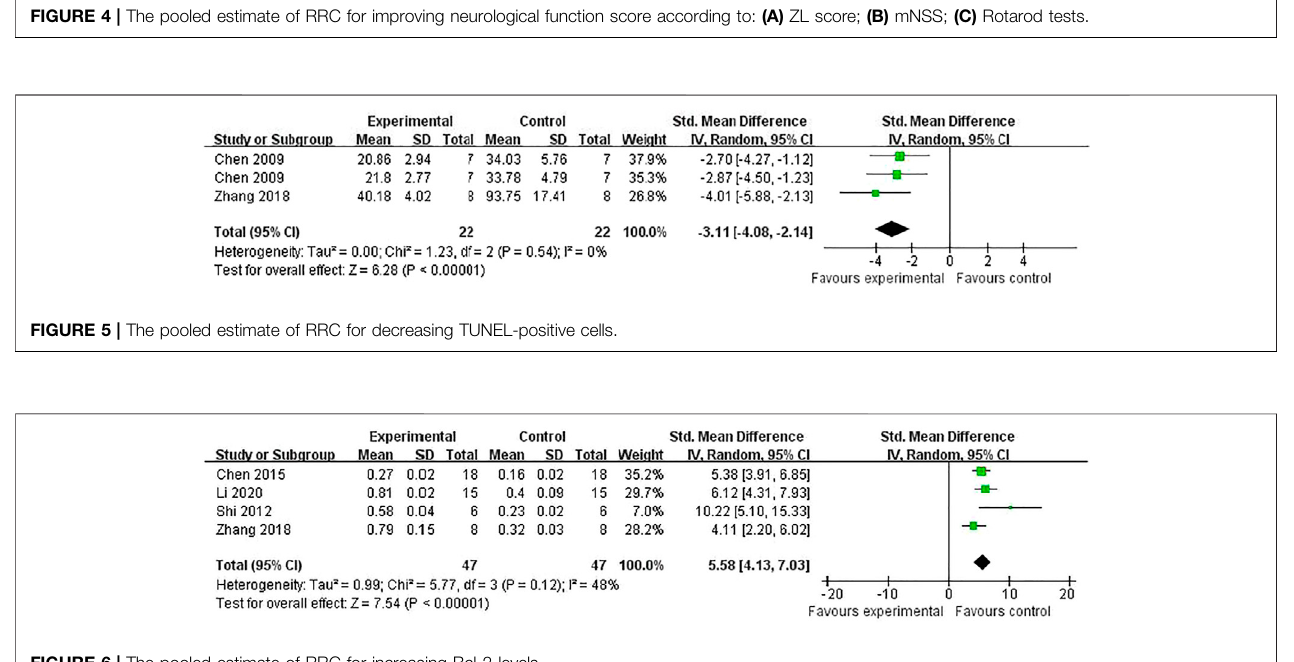
FIGURE 6 | The pooled estimate of RRC for increasing Bcl-2 levels.